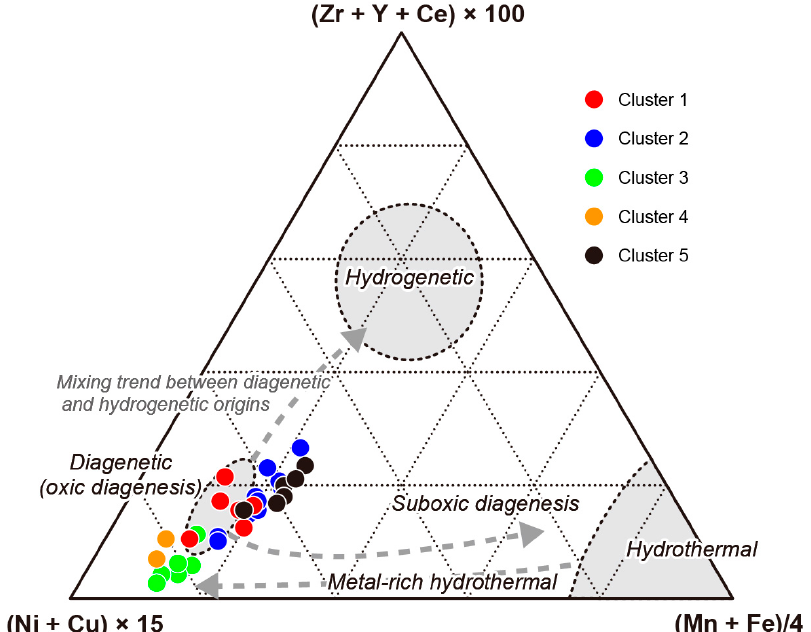
Figure 7. Ternary discrimination diagram for the genetic classification of oceanic Fe–Mn deposits [43]. All data for the Fe–Mn micronodule samples used in this study are plotted. The color-coding of the data points is the same as that in Figure 4.